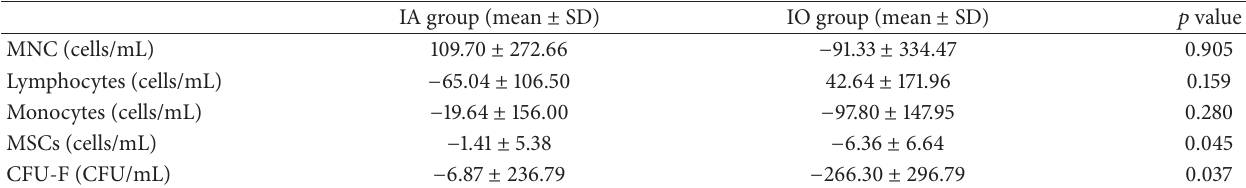
Table 4: Cellular increment ( 𝛿 ).